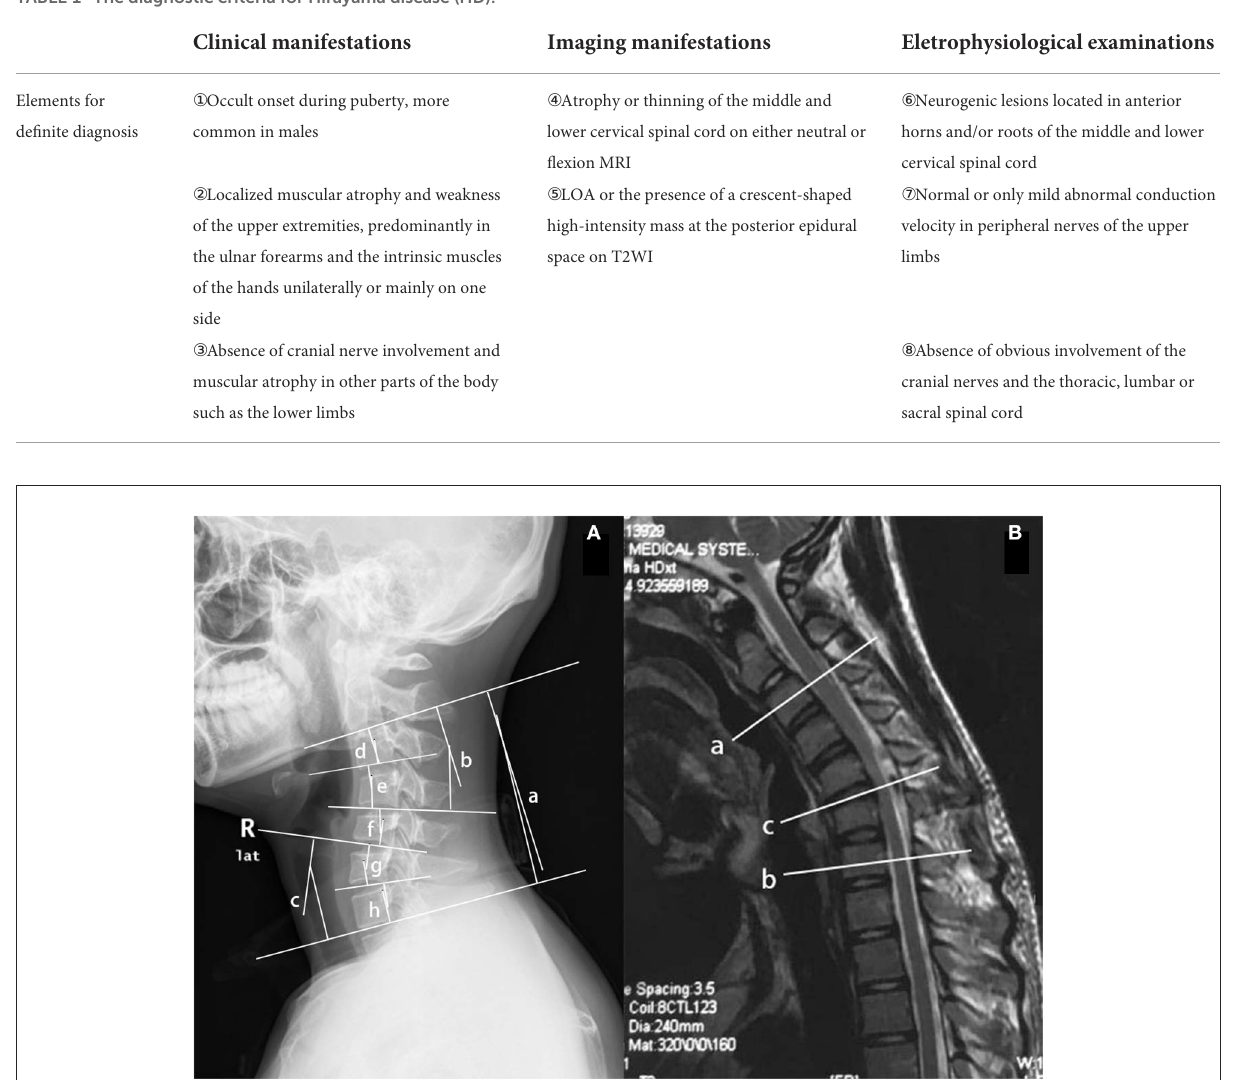
TABLE 1 The diagnostic criteria for Hirayama disease